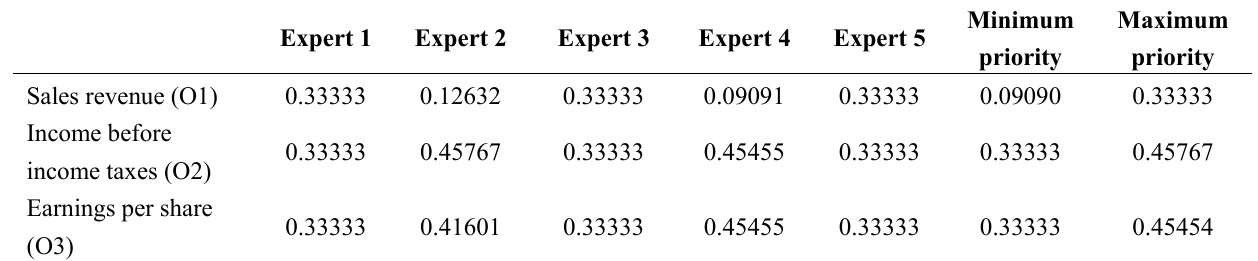
Table 10. Priorities of the outputs by the